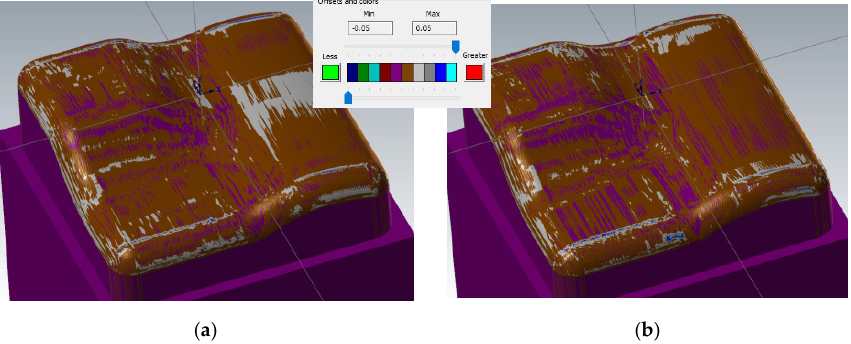
Figure 19. Comparison of the CAD model (Inventor) and the prediction of milled surface errors using 5-axis milling (Mastercam), ( a ) tool inclination β f = 5°, β n = 10° and ( b ) tool inclination β f = 10°, β n = 10°).